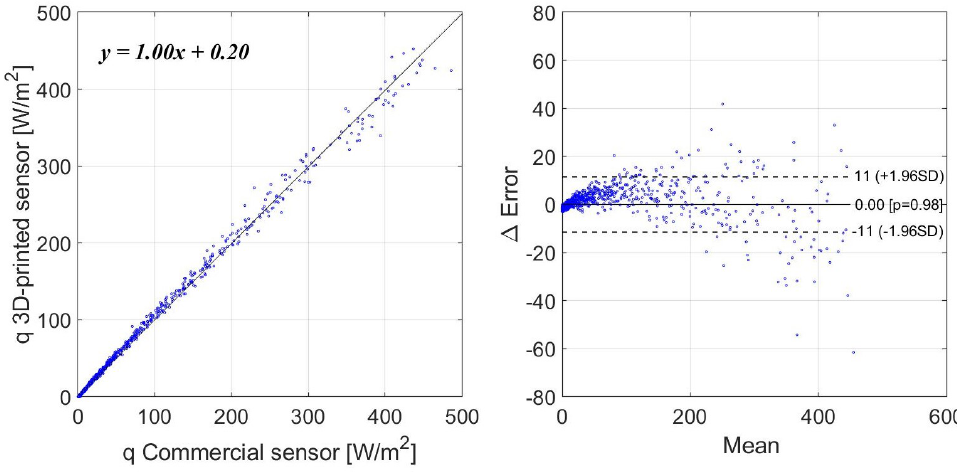
Figure 12. Bland–Altman analysis for short-term measurements and a wide